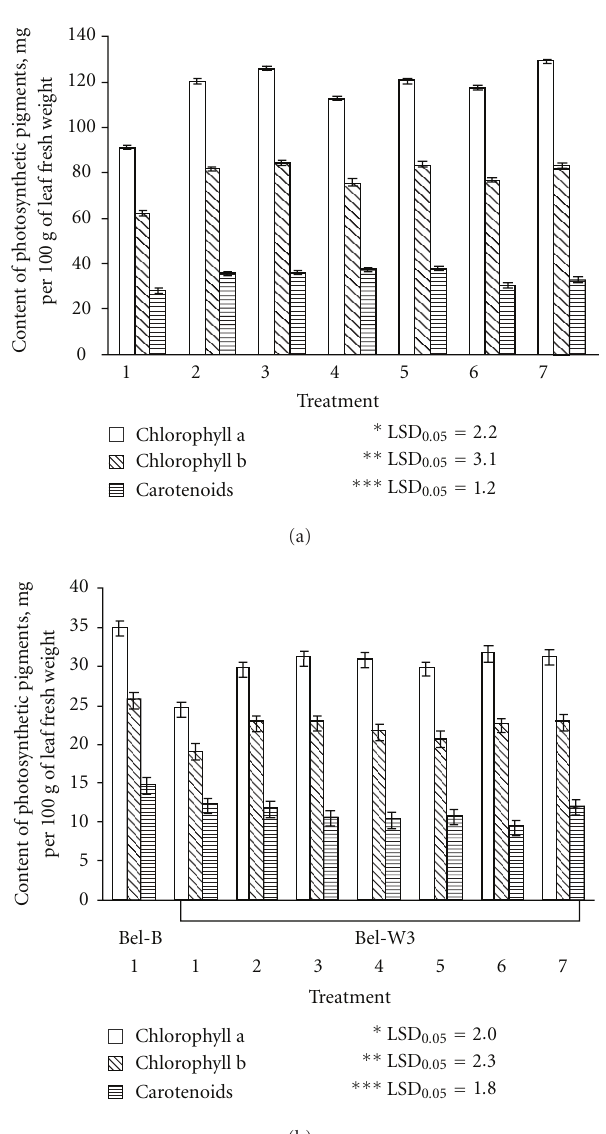
Figure 2: Content of photosynthetic pigments in leaves of clover (a) and tobacco (b) sprayed with distilled water (1), solutions of EDU, 150mg L − 1 (2), “Emistym C”, 150 mgL − 1 (3), “Agrostymulin” 150mg L − 1 (4), “Quadris”, 300 mgL − 1 (5), “Flint”, 300 mgL − 1 (6), “Strobi”, 300 mgL − 1 (7) on the last day of exposure to ambient ozone in Kyiv. Vertical bars represent standard error. LSD 0 . 05 : least significant di ff erence at P < 0 . 05 for ∗ chlorophyll a; ∗∗ chlorophyll b; ∗∗∗ carotenoids.